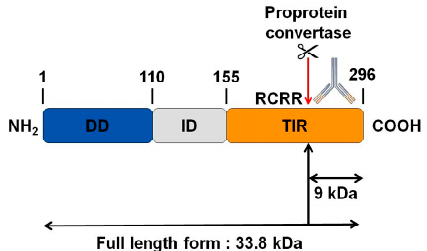
Figure 4. Bioinformatics analysis revealing a potential cleavage site for proprotein convertases in the C-terminal part of MYD88. While the molecular weight of MYD88’s full-length form is 33.8 KDa, such cleavage could release a C-terminal fragment of 9 KDa. The antibody used in the corresponding Western blot experiments is directed against the C-terminal part of MYD88. Thus it can detect MYD88’s full-length form and the cleaved C-terminal fragment of 9 KDa. DD: death domain; ID: intermediate